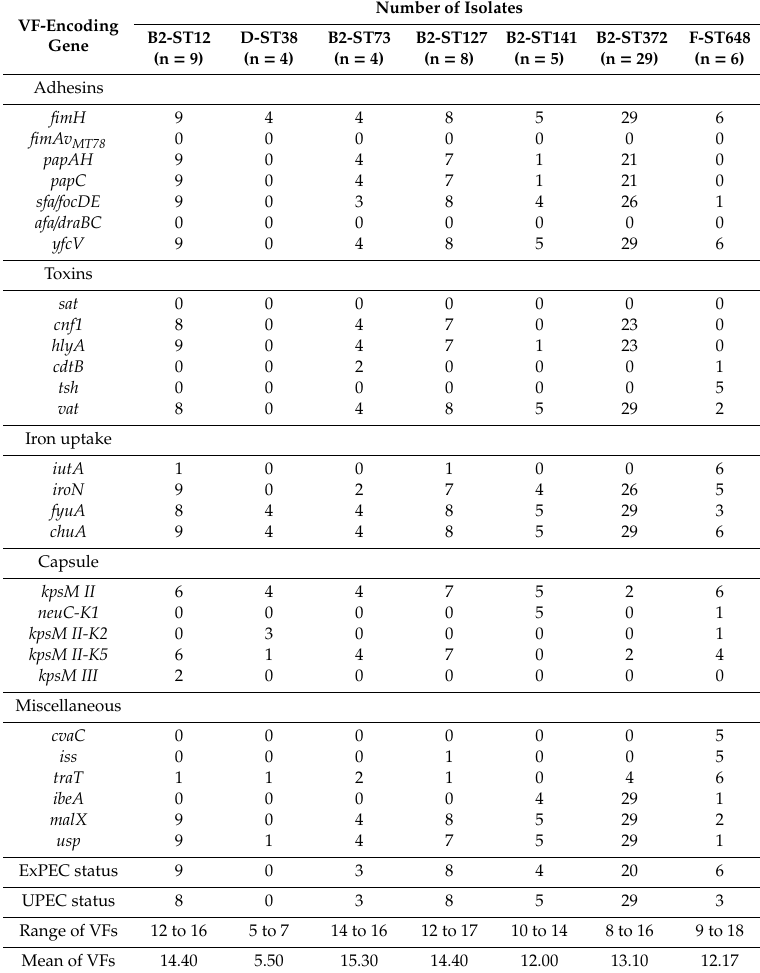
Table 2. Virulence factor (VF)-encoding genes detected in the 65 canine E. coli isolates included in the 7 most frequent sequence types identified in ExPEC, UPEC and MDR